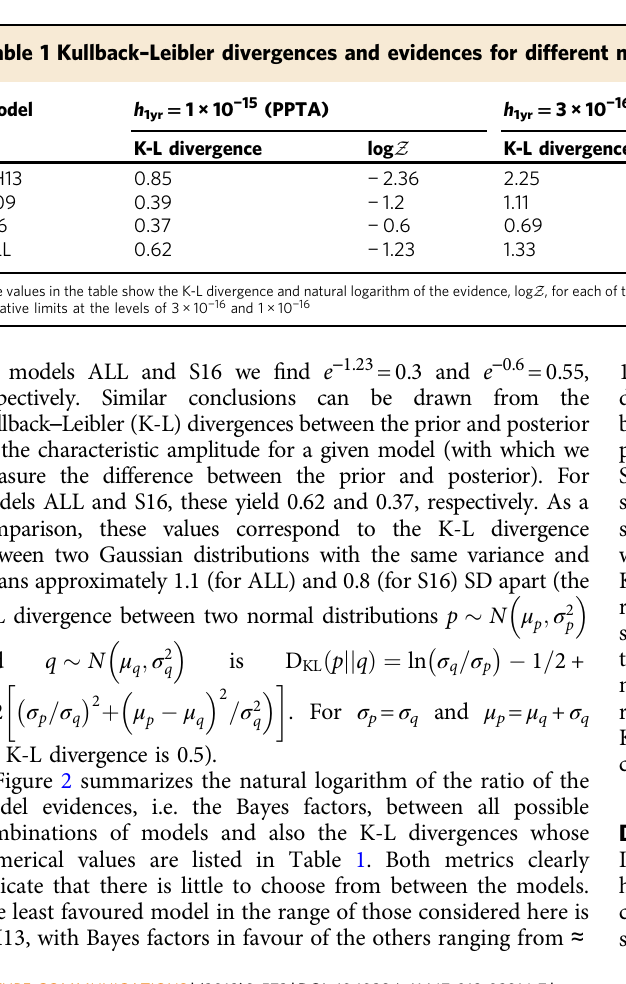
Table 1 Kullback – Leibler divergences and evidences for different models Model